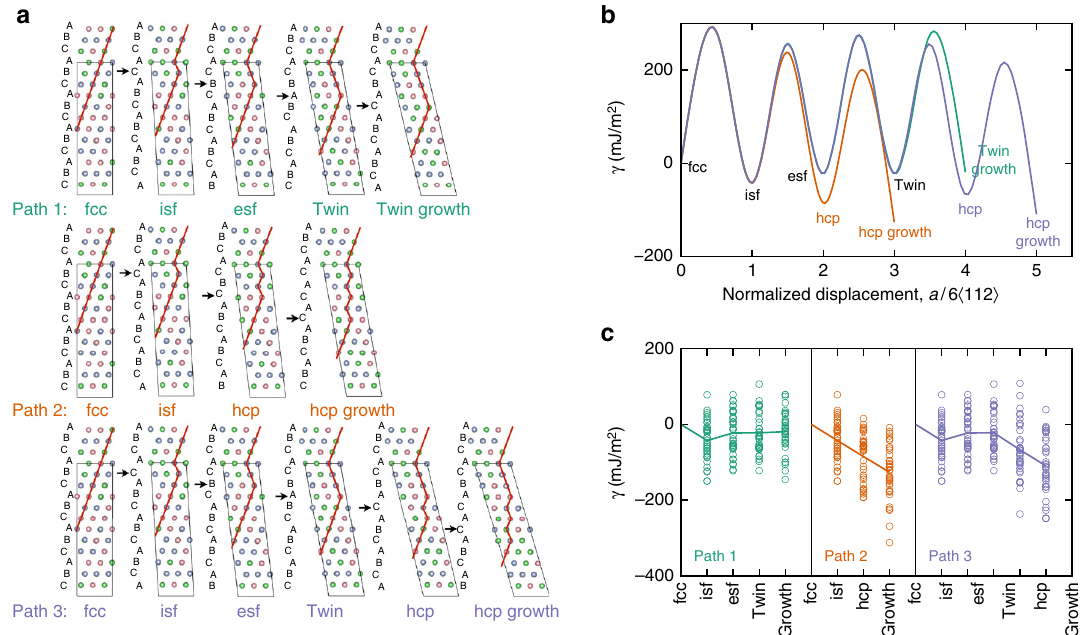
Fig. 5 Ab initio generalized planar fault energies versus normalized shear displacements on successive {111} planes in CrCoNi. a The supercells used to calculate the energetics of three paths: Path 1 twin formation and growth, Path 2: hcp formation, and subsequent growth, from an intrinsic stacking fault and Path 3: hcp formation, and subsequent growth, from a twin boundary. Starting from the fcc structure, one-layer intrinsic fault (isf), two-layer extrinsic fault (esf) and three-layer twins are created by introducing Shockely partials with b ¼ 1 = 6 112 h i on adjacent {111} planes. The hcp stacking is obtained by skipping one plane and introducing the next partial on the second neighboring plane. Black arrows indicate the successive planes where Schockley partials are introduced. b The fault energies, averaged over 36 con fi gurations with different local chemistry at the fault plane. c The corresponding energies of all 36 con fi gurations with average values marked by solid